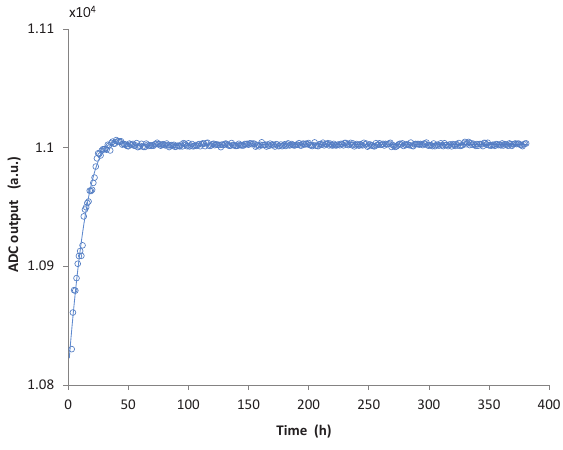
Figure 12. Drift of the sensor during the first fifteen days of in vitro